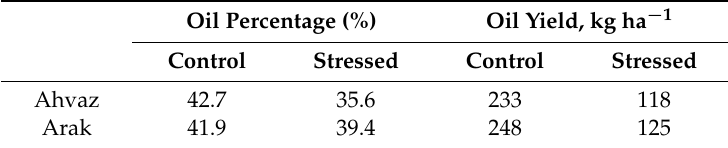
Table 2. Oil percentage and oil yield in the field experiment. Modified from